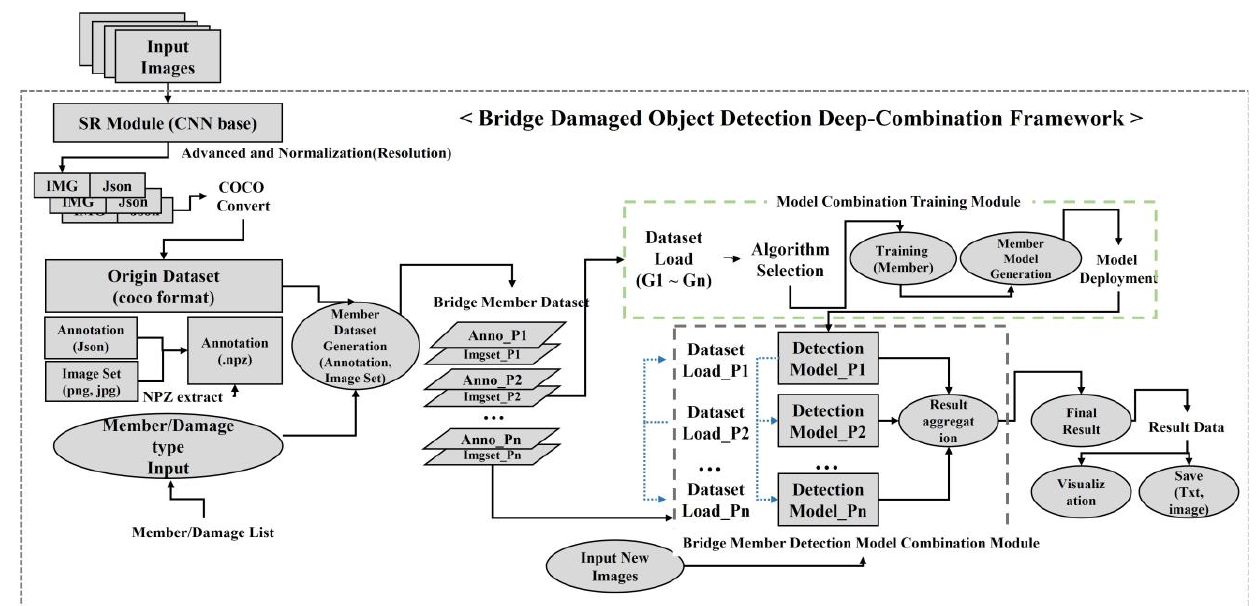
Figure 3. Proposed bridge damaged-object-detection deep-combination framework (BDODC-F).